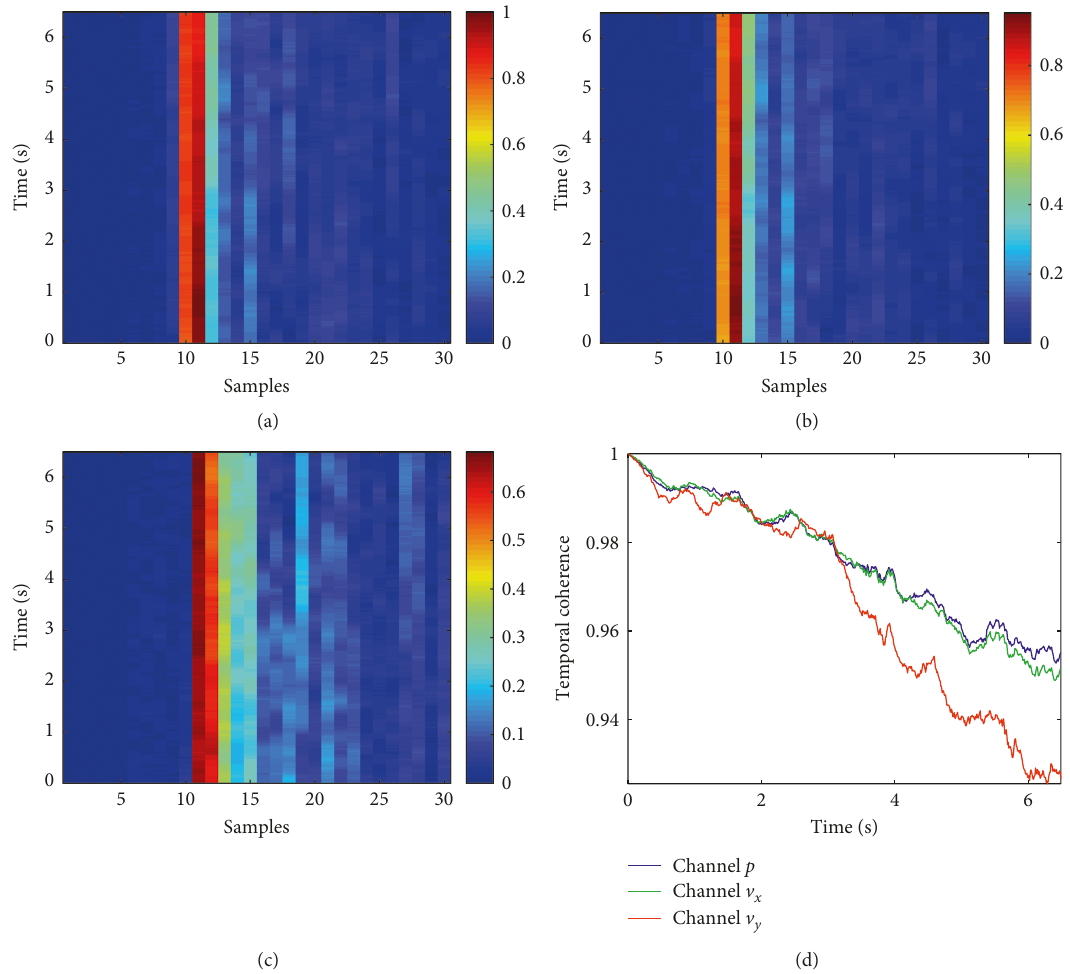
v x channel; (c) the CIR for the y channel;